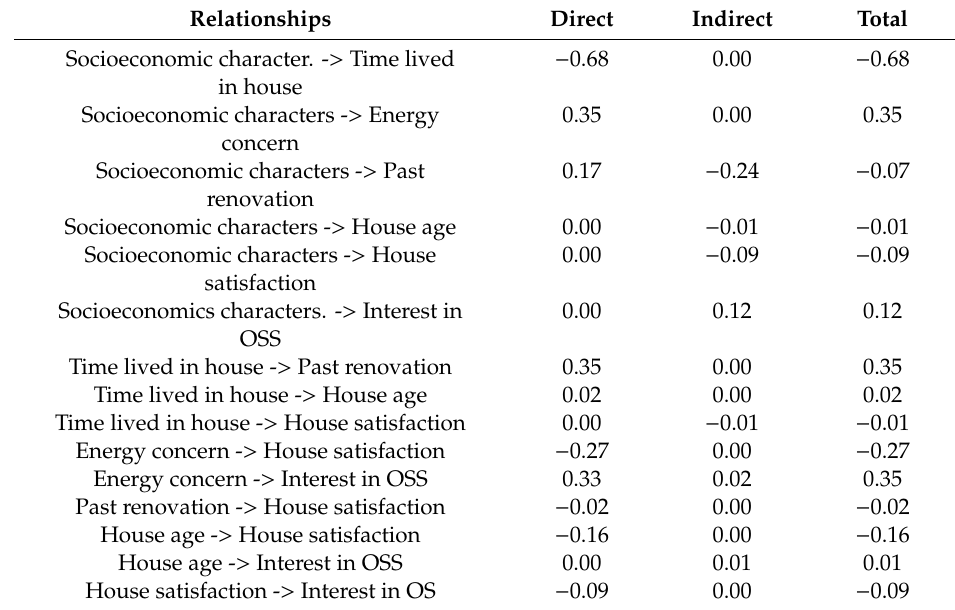
Table 4. Direct, indirect and total e ff ects in the one-stop-shop (OSS) model. Relationships Direct Indirect Total Socioeconomic character. - > Time lived −